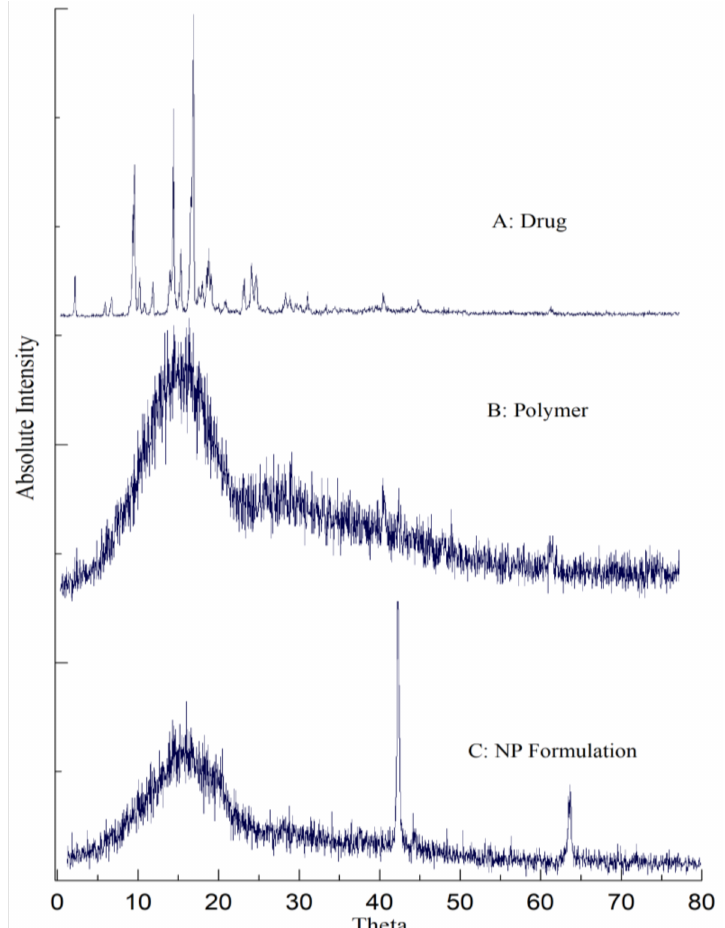
Figure 5. PXRD spectra for ( A ) pure drug, ( B ) polymer and ( C ) RIS-loaded